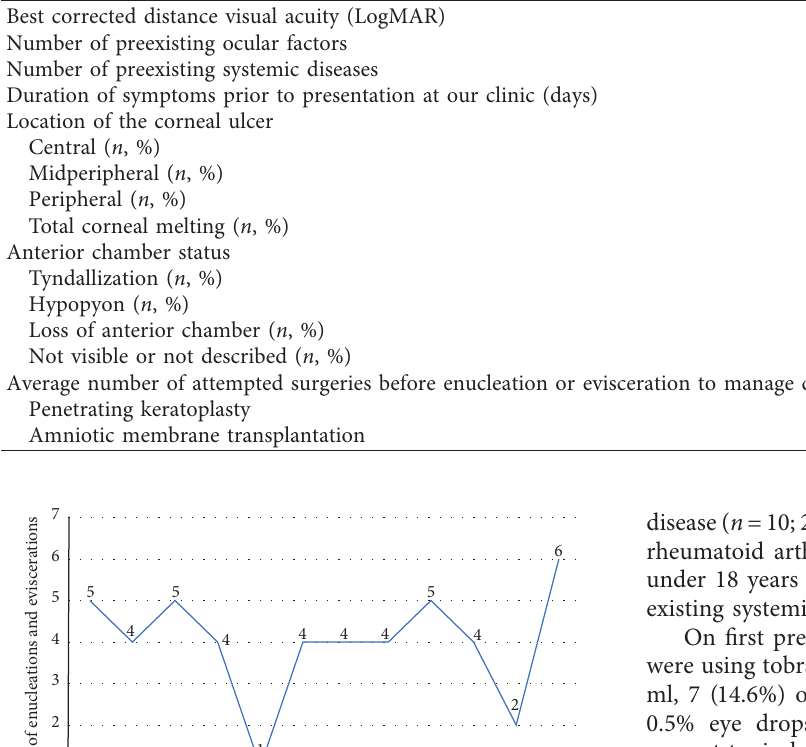
Table 2: Medical characteristics of patients who underwent enucleation or evisceration due to infectious keratitis between January 2007 and December 2018 at the Department of Ophthalmology of Semmelweis University (Budapest, Hungary) (48 eyes of 47 patients). Best corrected distance visual acuity (LogMAR)